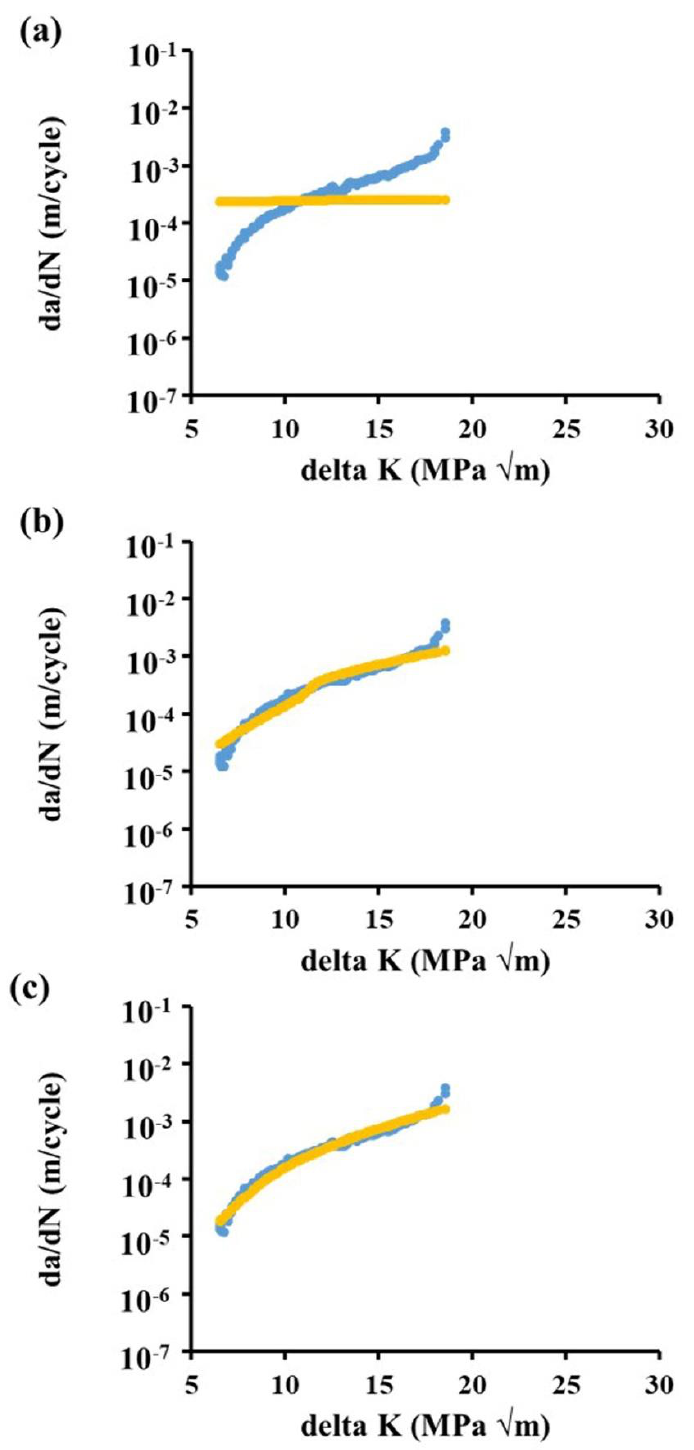
Figure 4. Influence of epochs of back propagation neural networks (BPNN) on CR250 samples: ( a ) 1 epoch, ( b ) 5 epochs and ( c ) 10